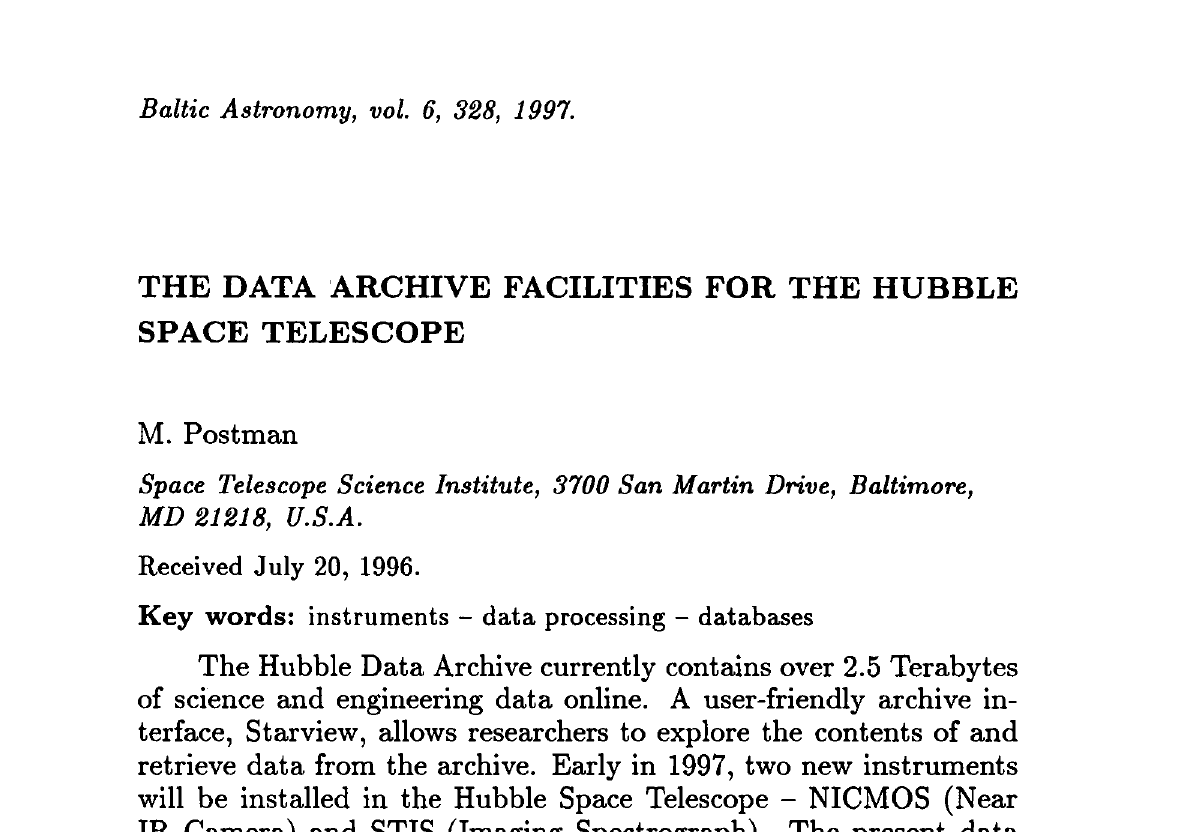
IR Camera) and STIS (Imaging